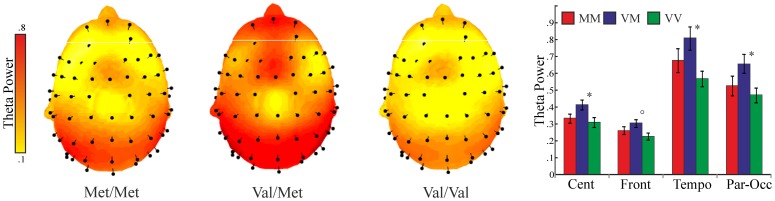
Topographic plots of power in the theta frequency band.Graph represents averaged values for central, frontal, temporal and parieto-occipital regions, per each genetic group. Bars represent standard error. * p<0.05;° p<0.06 according to post-hoc Tukey-Kramer comparisons (Val/Met vs Val/Val).